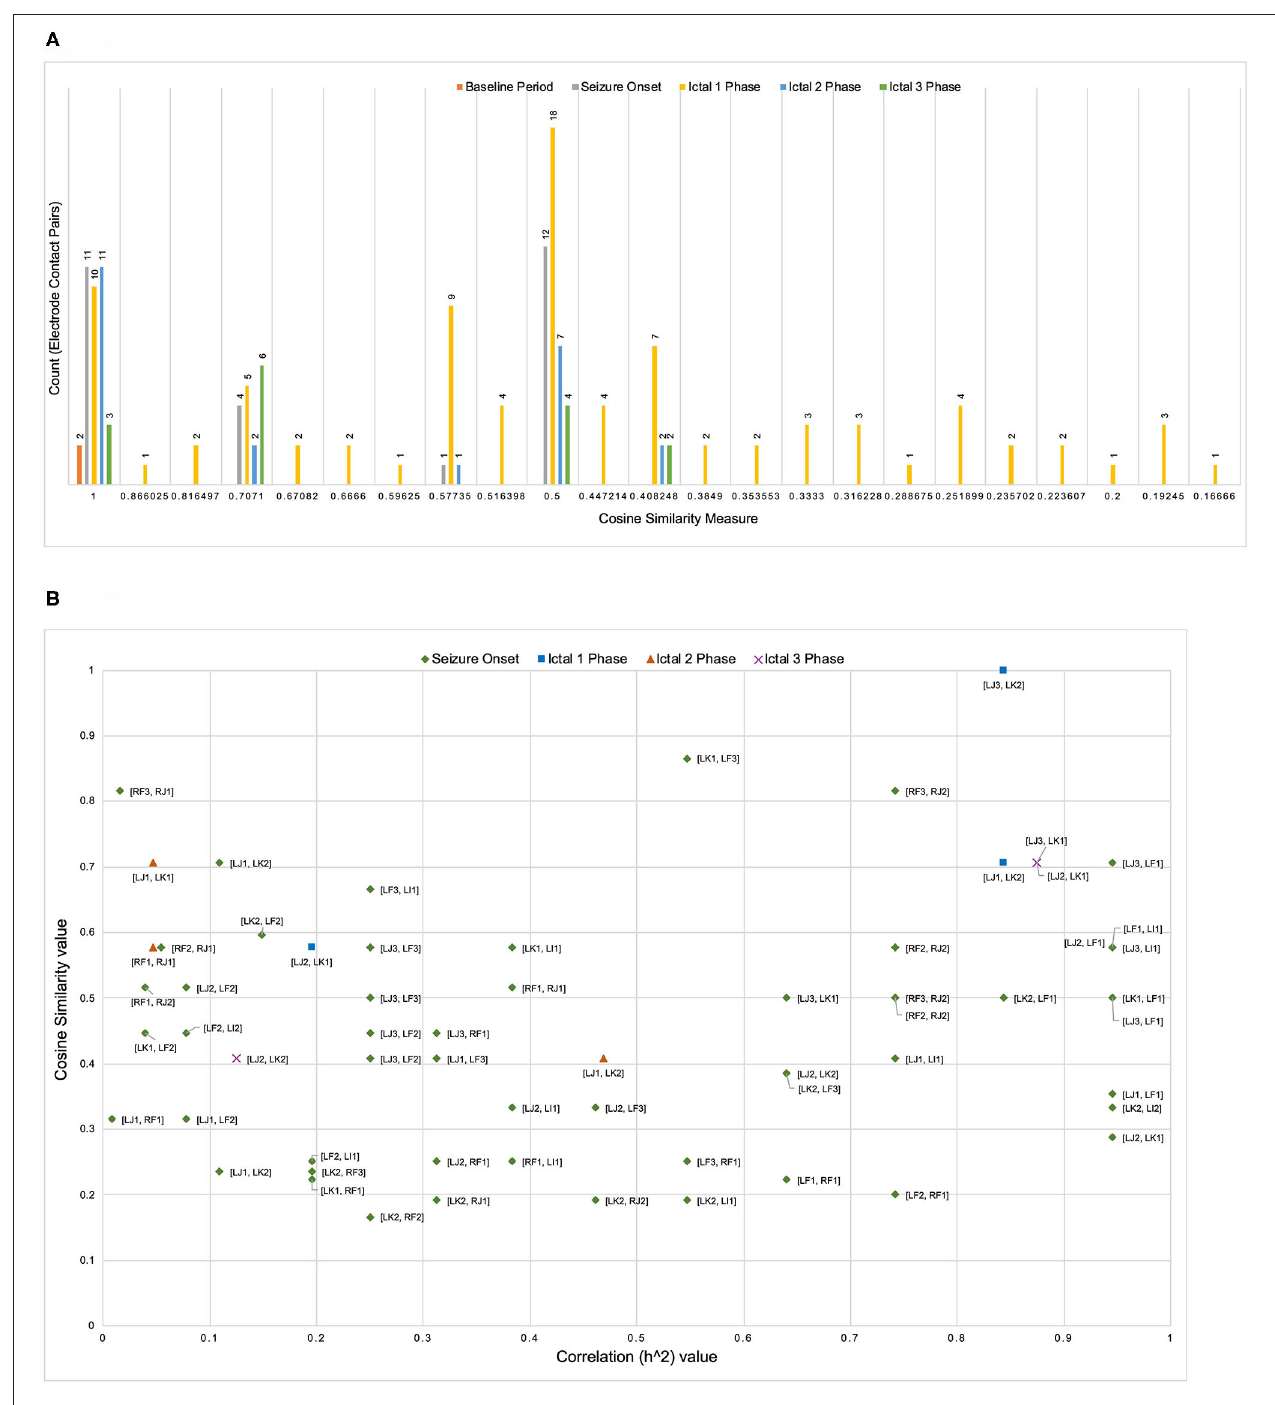
FIGURE 4 | (A) The clustering of cosine similarity values for electrode pairs according to baseline, seizure onset, and ictal events in 27 events across 8 seizures shows significant increase in interactions between electrode pairs during ictal 1 phase as compared to any other event (including baseline event) The figure does not include a bin for cosine similarity value of 0 (a figure with bin for cosine similarity value of 0 is available as Supplementary File ). (B) For seven pairs of electrode contacts that had non-zero cosine similarity values across multiple seizure events (in addition to ictal 1 phase) there is no association between correlation values and cosine similarity